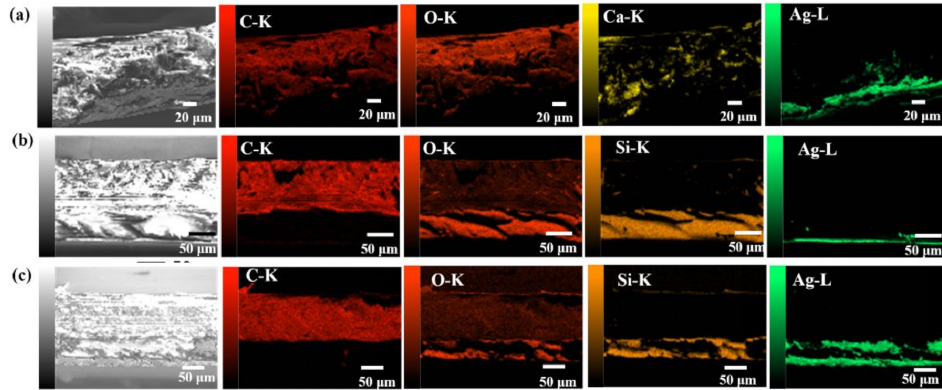
Figure 5. SEM-EDS for cross section of ( a ) paper-print-based SERS substrate; ( b ) PET-print-based SERS substrate; ( c ) PET-HD-based SERS